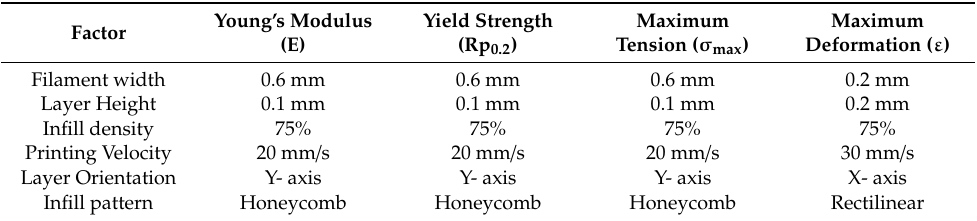
Table 7. Parameters’ level to maximize the response.